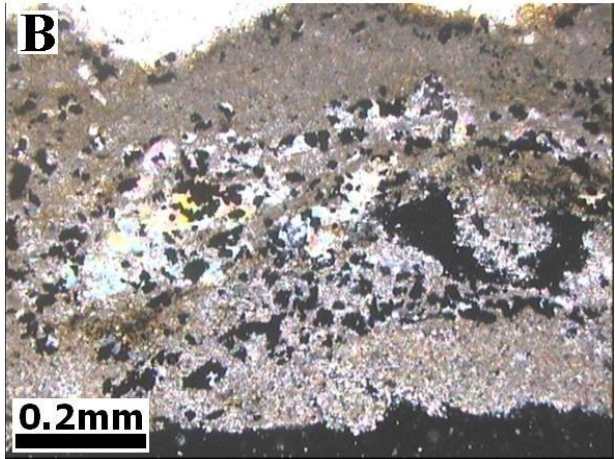
Figure 8. Scattered sulfide grains in a marl